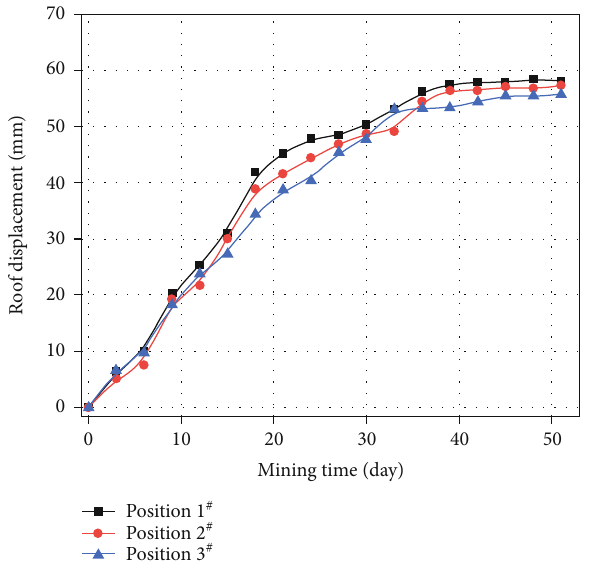
Figure 11: Deformation law of roadway roof.